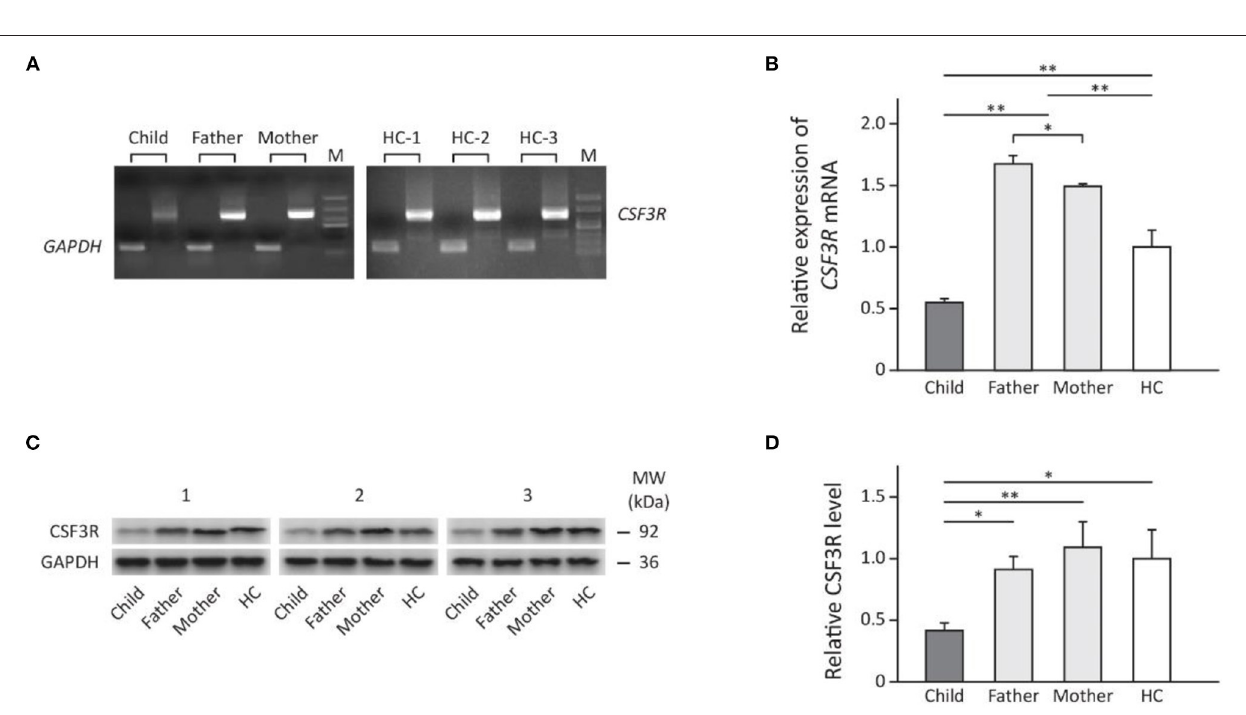
FIGURE 3 | The expression of CSF3R in the family measured by: (A) direct PCR using cDNA transcription of total RNA extracted from subject’s neutrophils; (B) rt-PCR showing fold change of relative CSF3R expression (normalized to GAPDH ) compared to healthy controls. (C) Western blot ( n = 3) and (D) the relative levels of CSF3R protein in neutrophils adjusted by GAPDH (Quantification of band intensities was performed using ImageJ). Results are presented as mean ± SD, * p < 0.05, ** p < 0.01. HC, healthy control; M, marker; MW, molecular